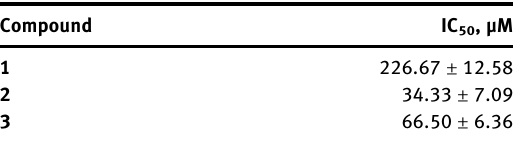
Table  : IC  values of compounds  –  for L  cells after  h incubation.